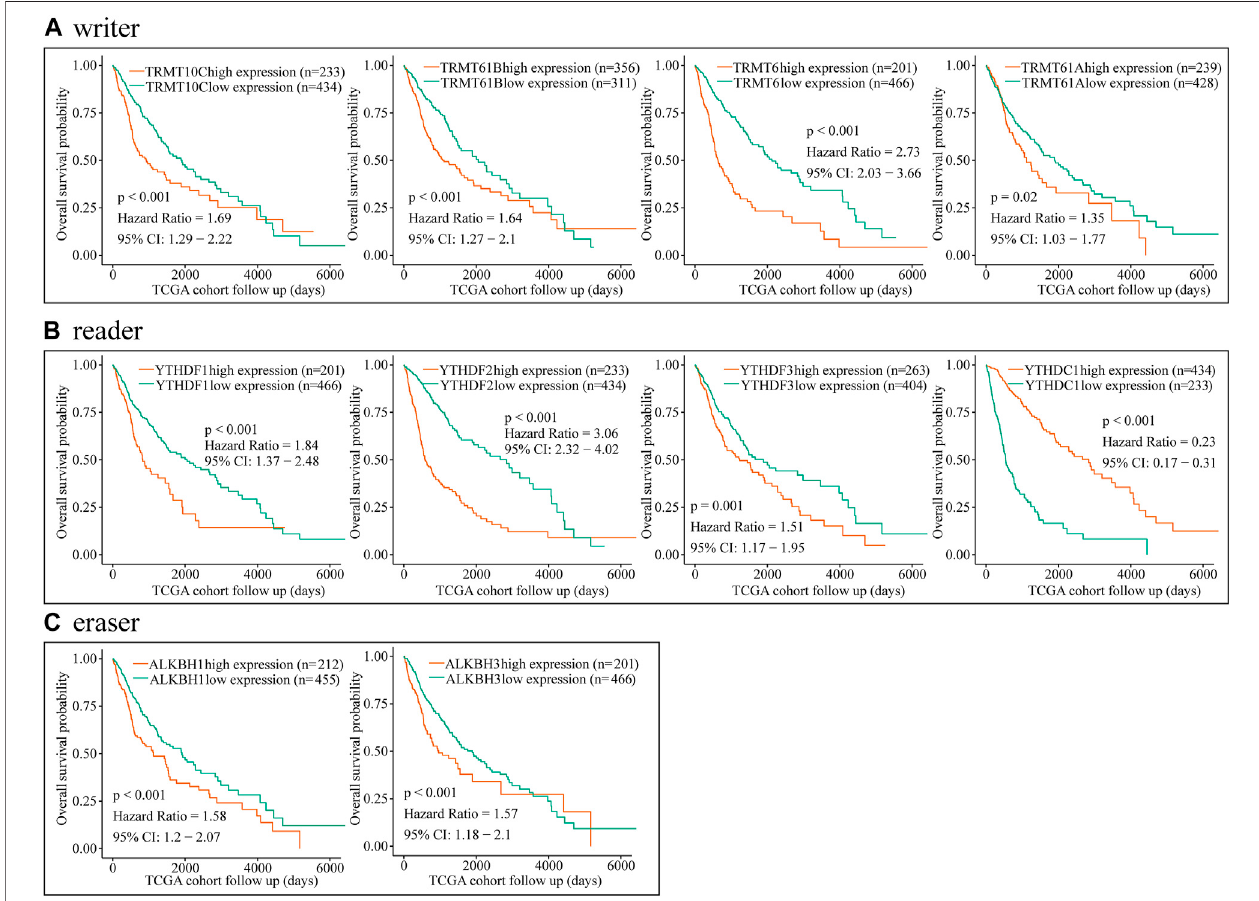
FIGURE 3 | Prognostic value of the m1A regulators in glioma based on TCGA dataset. (A – C) Kaplan – Meier analysis showing the correlation between m1A “ writers, ” “ readers, ” and “ erasers ” expression levels and the glioma patients overall survival rates based on TCGA